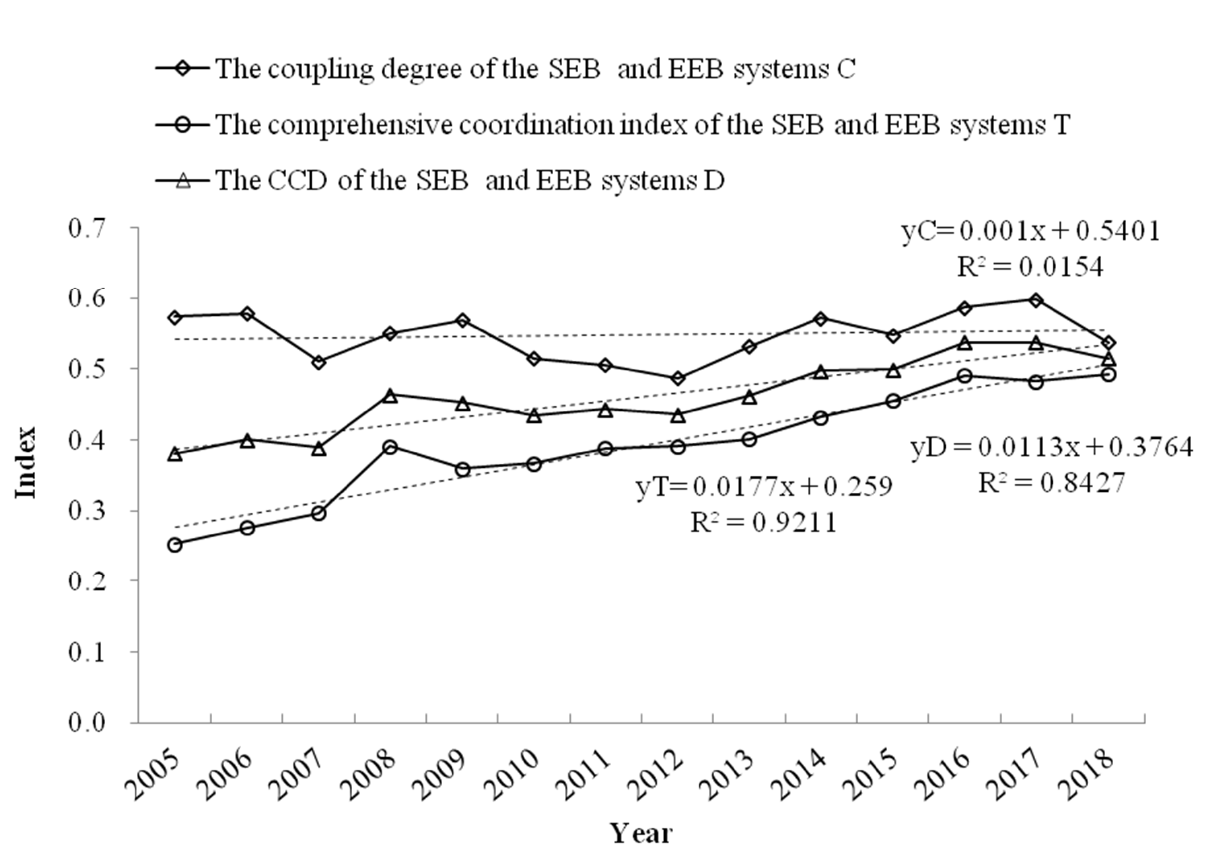
Figure 5. Evolving curve of the CCD of the SEBs and EEBs systems for the Koktokay Global Geopark from 2005 to 2018.